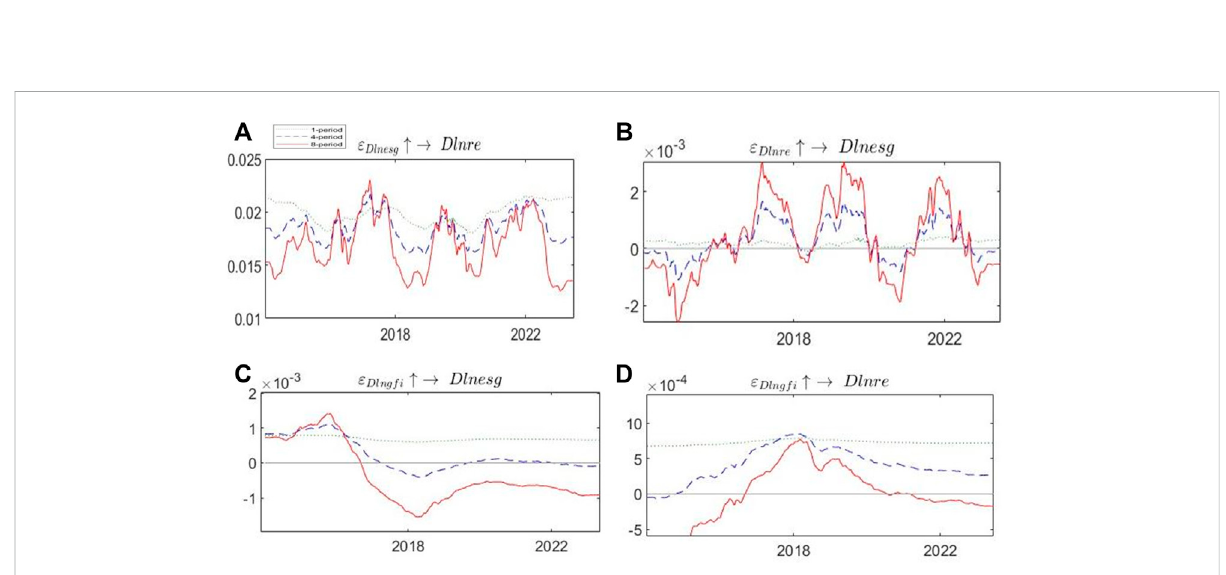
FIGURE 7 Plotoftheequal-intervalimpulseresponsefunction. (A) Theequal-intervalimpulseresponseofsustainabledevelopmenttorenewableenergy, (B) theequal-intervalimpulseresponseofrenewableenergytosustainabledevelopment, (C) theequal-intervalimpulseresponseofgreen fi nanceto sustainable development, and (D) the equal-interval impulse response of green fi nance to renewable